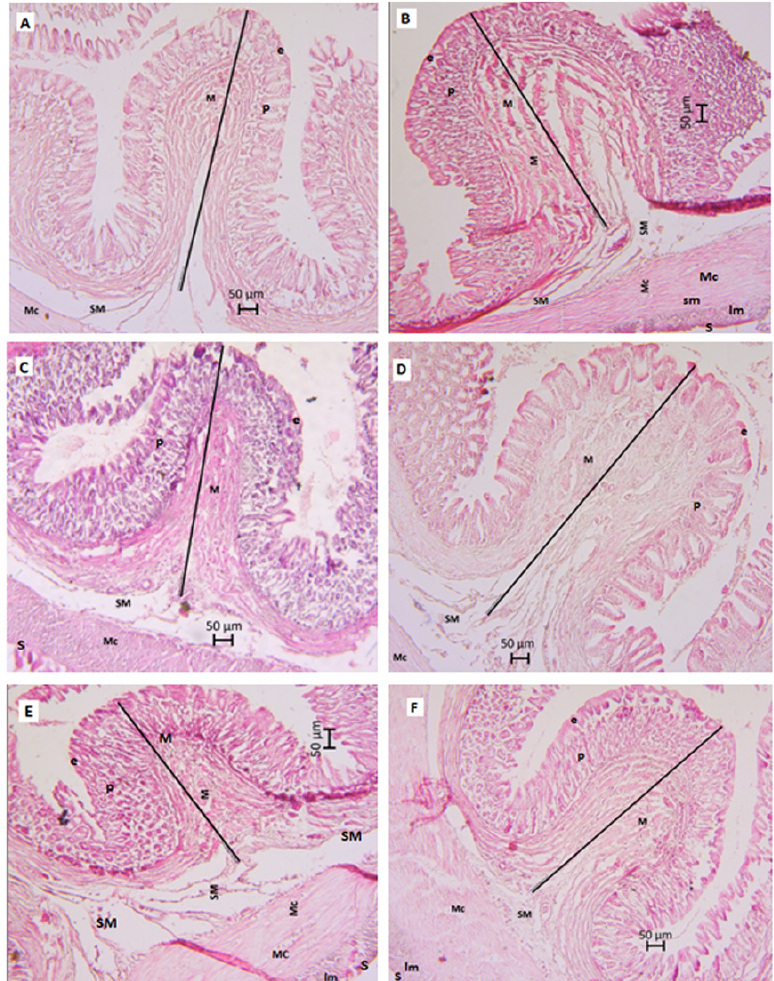
Figure 1. Histological sample of the giant trevally ( Caranx ignobilis ) foveola gastrica. ( A ) Feed without added activated charcoal (control). ( B ) Feed with 1% rice husk activated charcoal. ( C ) Feed with 1.5% rice husk activated charcoal. ( D ) Feed with 2% rice husk activated charcoal. ( E ) Feed with 2.5% rice husk activated charcoal. ( F ) Feed with 3% rice husk activated charcoal. M, Tunica mucosa; e, epithelium lamina; p, lamina propria; SM, submucosal tunica; Mc, muscular tunica; S, serous tunica; lm, longitudinal muscles.